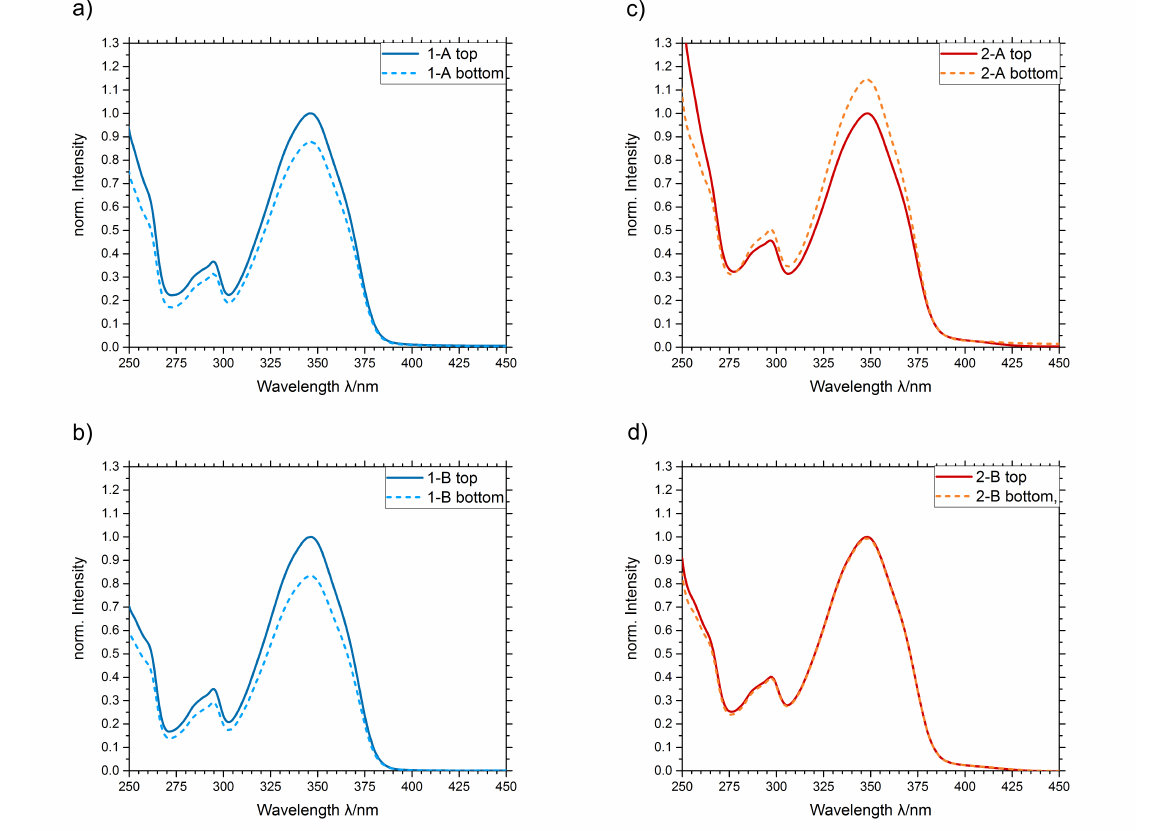
Figure 7. Absorption spectra of the produced preforms. Solid lines represent the samples from the top, dashed lines represent the samples from the bottom of the preforms. ( a ) Sample 1-A. ( b ) Sample 2-A. ( c ) Sample 1-B. ( d ) Sample